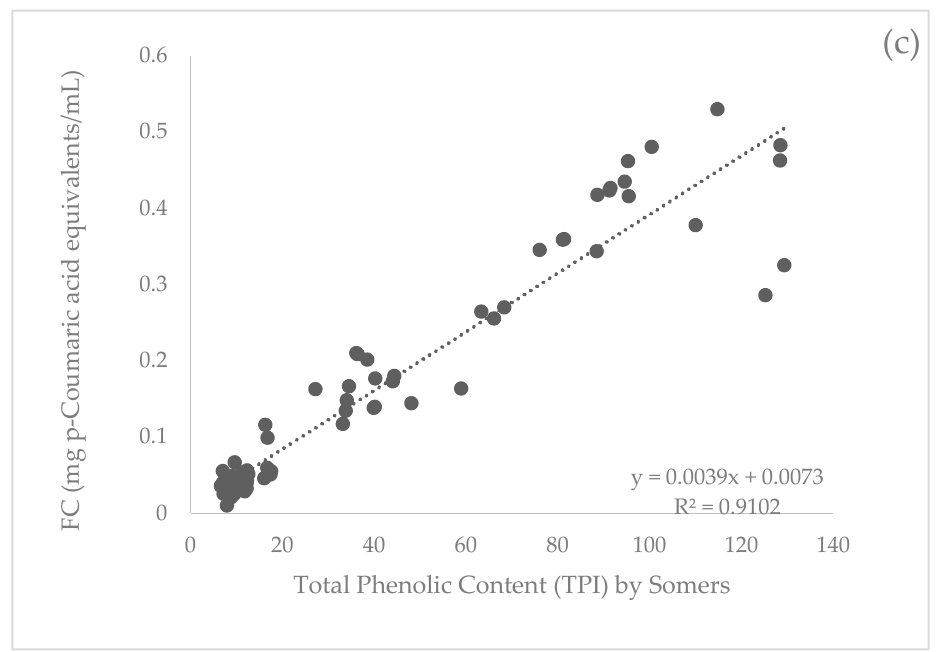
Figure 1. Correlation (Pearson’s) between total phenolic measurement methods ( a ) Somers and ultra-performance liquid chromatography (UPLC), ( b ) Folin-Ciocalteu (FC) and UPLC, and ( c ) Somers and FC for all samples ( n = 154).